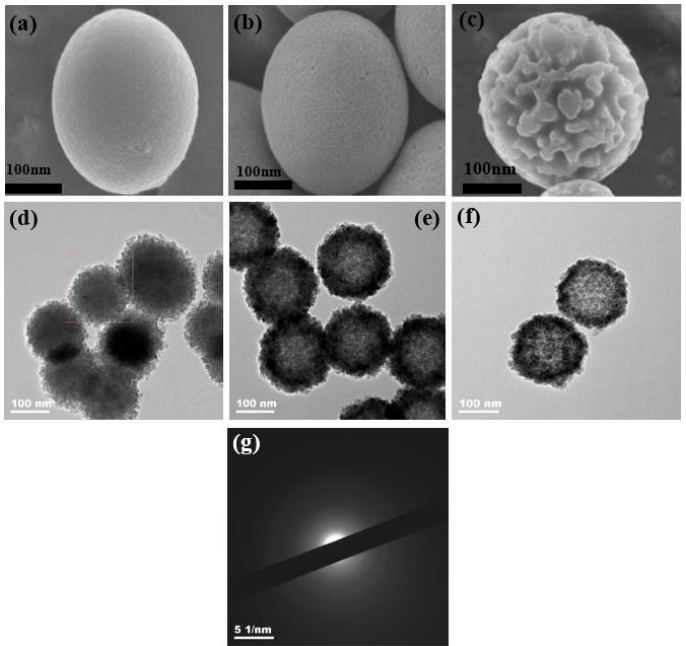
Figure 4. SEM images of the samples: ( a ) A1h, ( b ) A3h and ( c ) A6h. TEM images of the samples: ( d ) A1h, ( e ) A3h and ( f ) A6h. ( g ) SAED pattern of A1h.